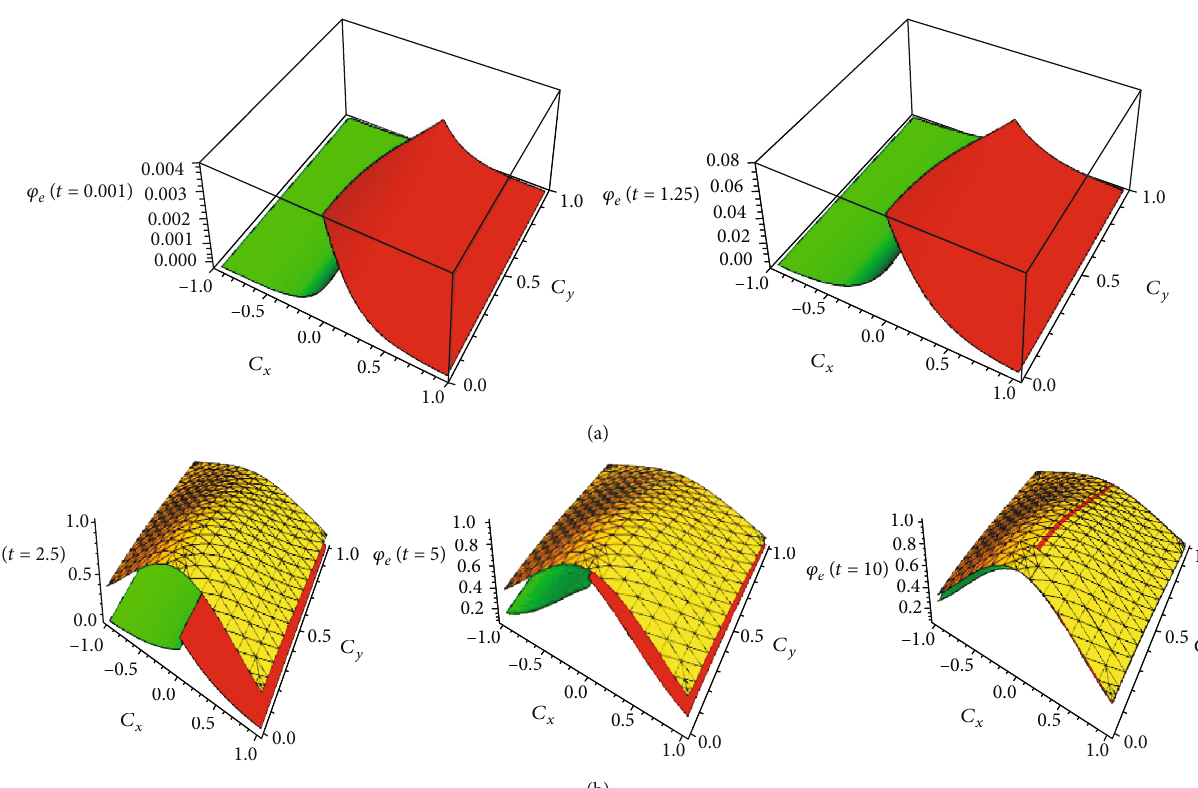
Figure 1: (a) The perturbed electron velocity distribution functions φ with the Mach number of the plate M = 0 : 01 . (b) The combination of the perturbed electron velocity distribution functions φ φ (red) compared to the equilibrium velocity distribution function φ 2 at y = 1